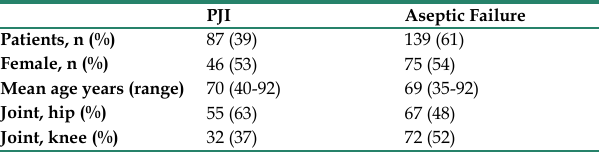
Table 1. General patient characteristics.